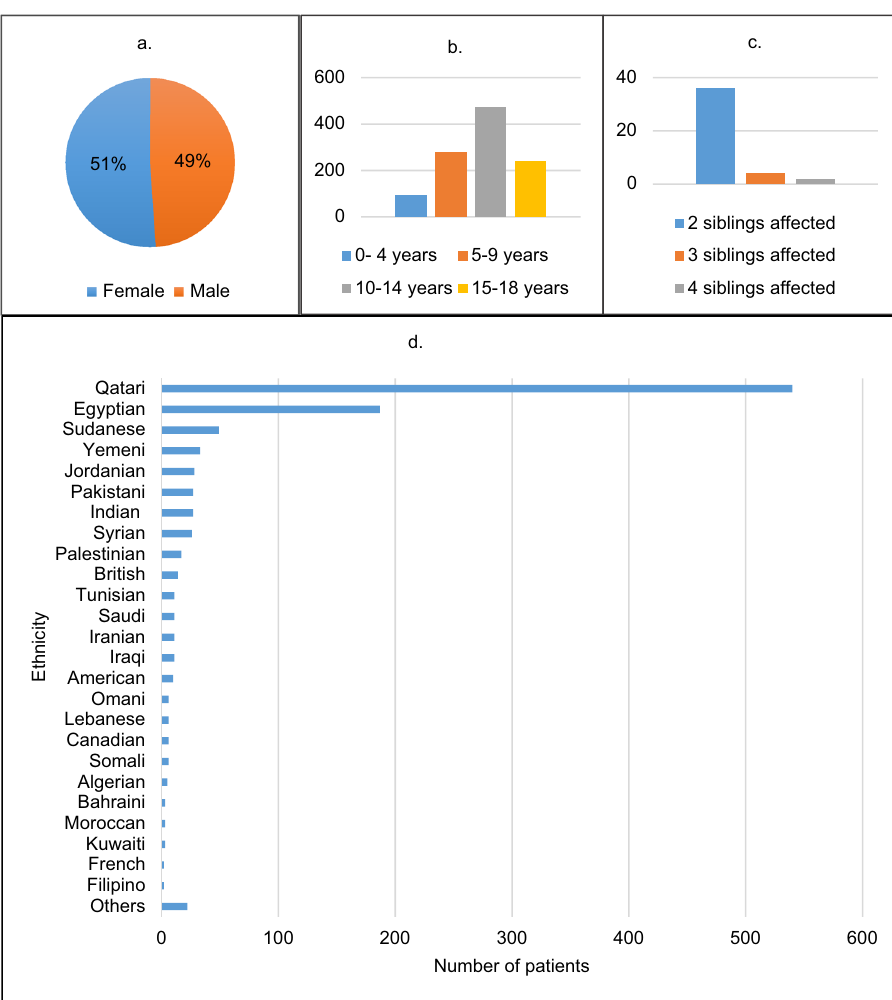
Figure 1. Summary of clinical features of type 1 diabetes mellitus patients. ( a ) Gender distribution of patients. ( b ) Age distribution of patients. ( c ) Number of families with multiple siblings with type 1 diabetes mellitus. ( d ) Ethnicity of type 1 diabetes mellitus patients.